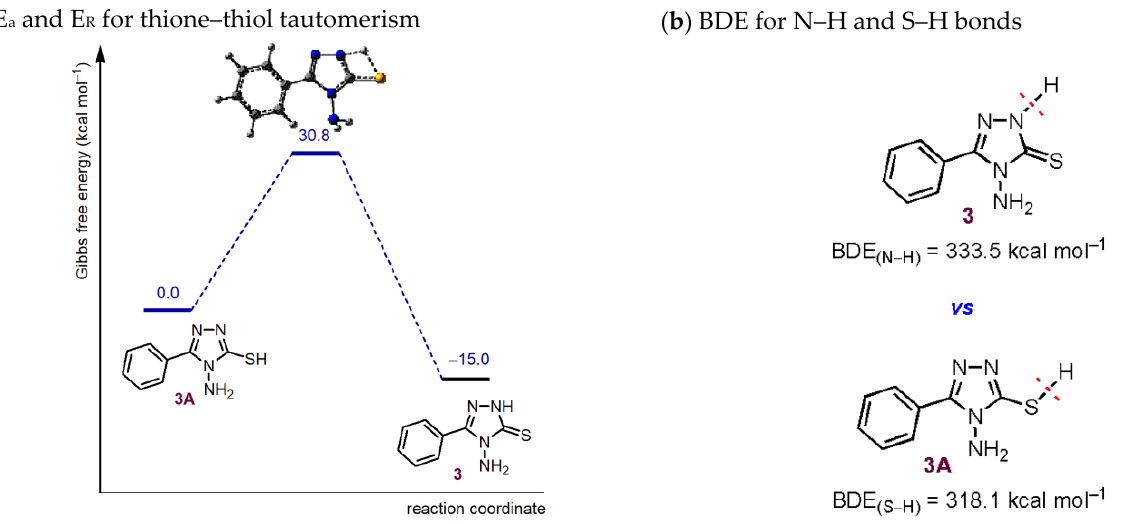
Figure 7. Energy of activation (E a ) and reaction energy (E R ) for the thione – thiol tautomers ( 3 ) and ( 3A ) ( a ) and bond dissociation energies (BDE) for N – H and S – H bonds in thione 3 and thiol 3A structures, respectively, ( b ), computed at B3LYP/6-31+G(d,p) level of theory.